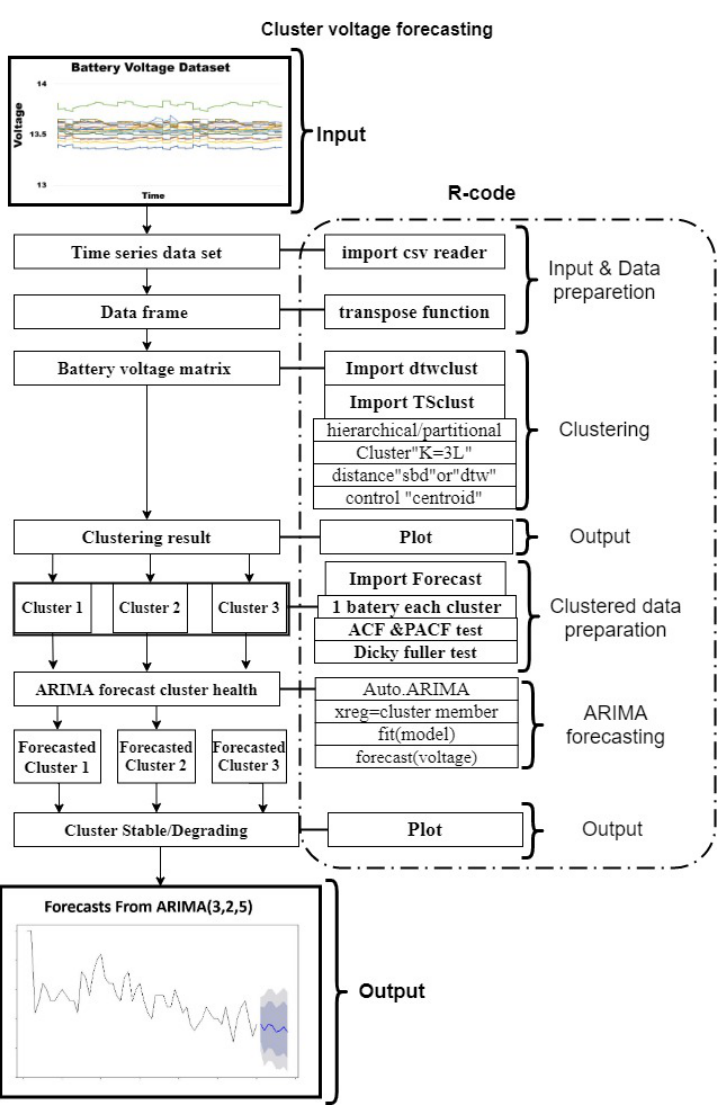
Figure 3. Battery cluster inconsistency and battery degradation forecast